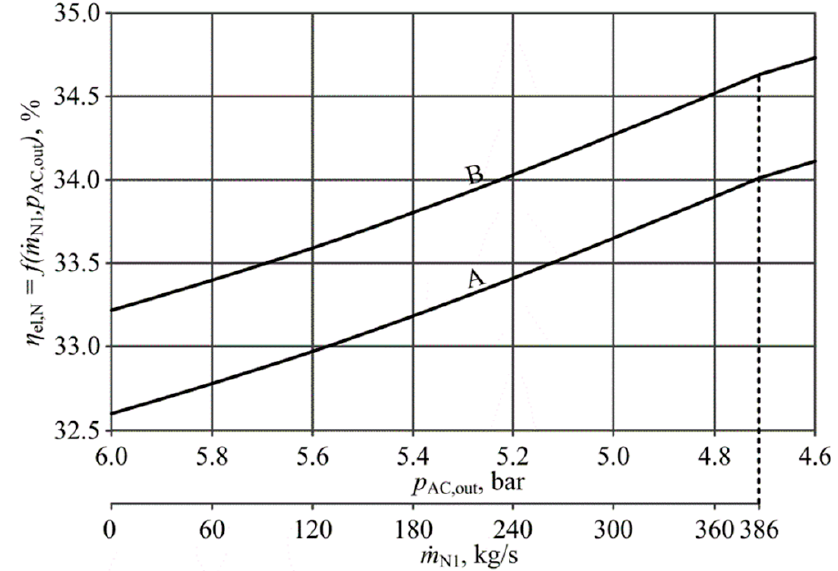
Figure 18. Net efficiency of electricity generation as a function of the air compressor’s outlet pressure and the drying medium’s flow rate (Variant V1 of the oxy-type power plant).